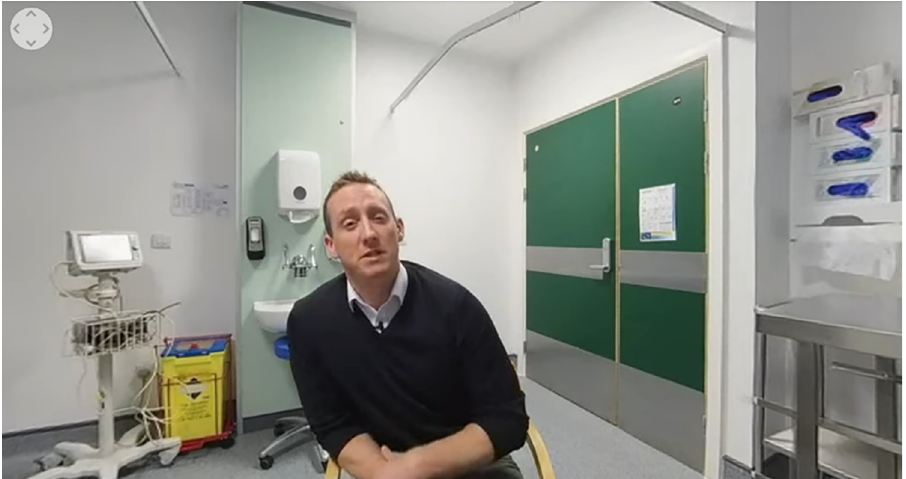
Fig 1. Screenshot of the active VR scenario. Reproduced with permission from